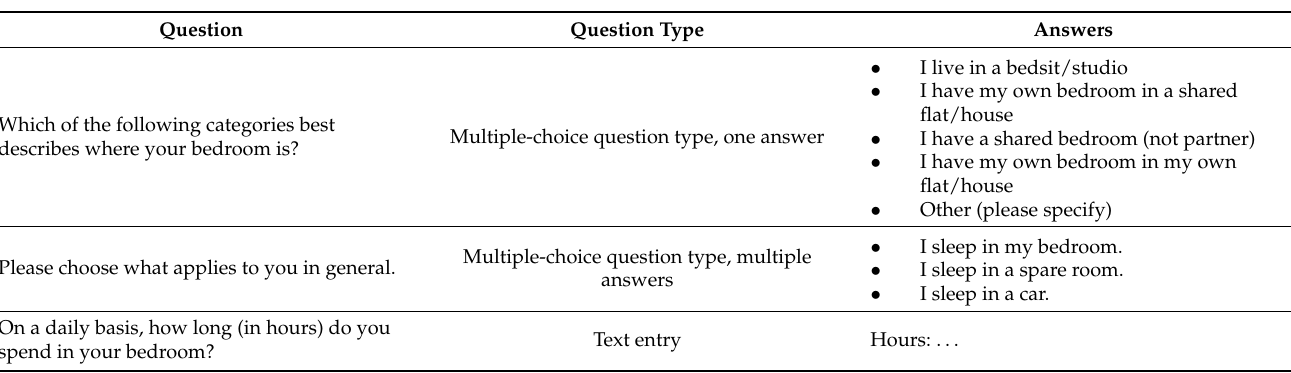
Table 3. Questionnaire items related to spatial characteristics and participants’ use of the sleep